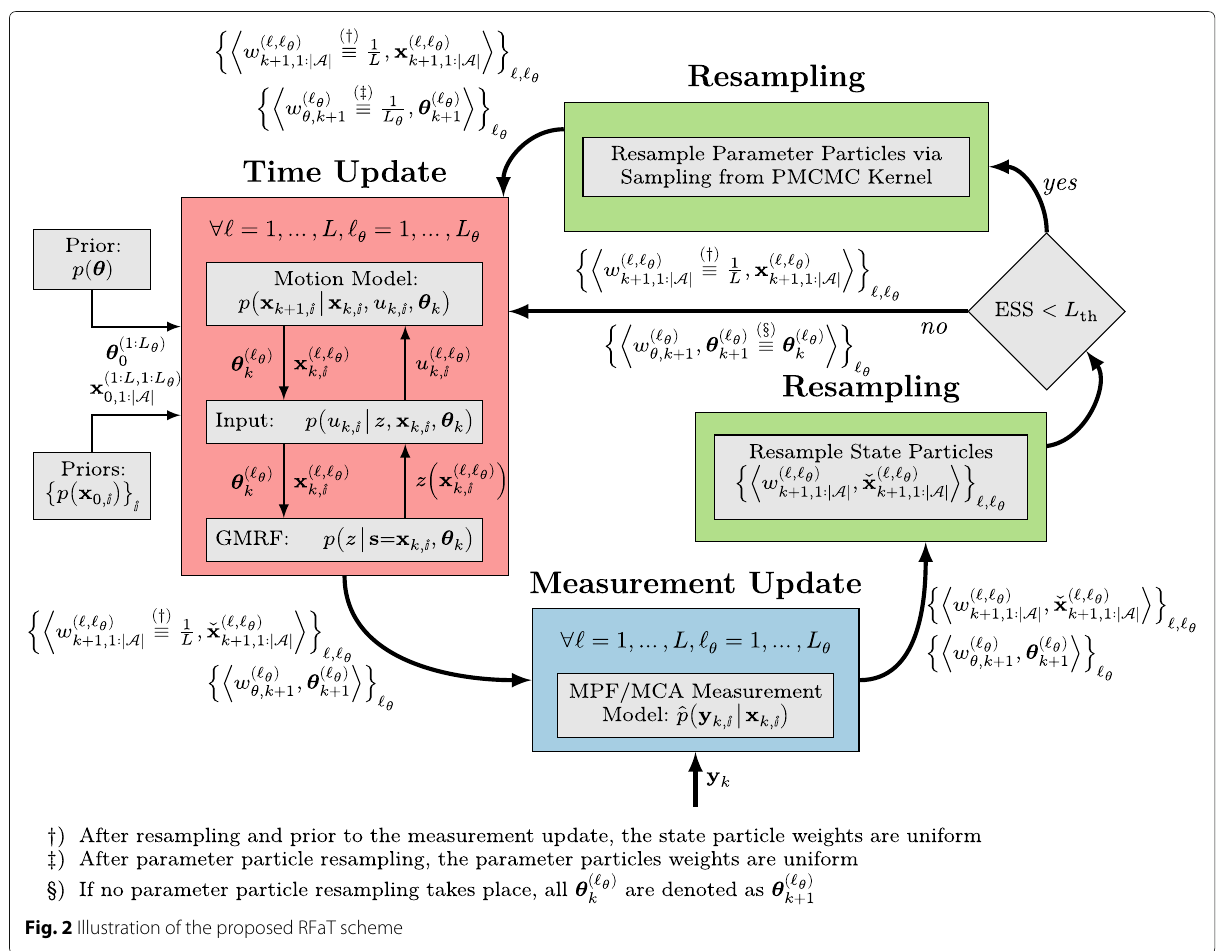
Fig. 2 Illustration of the proposed RFaT scheme